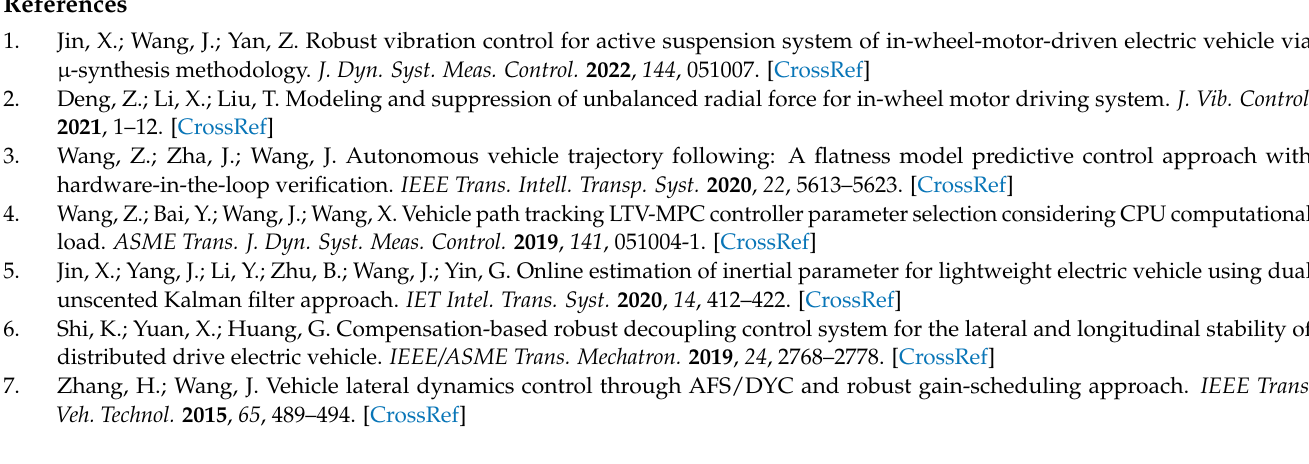
V  ). Figure 17. Additional torque of the path tracking stability controller at higher speed ( V x = x